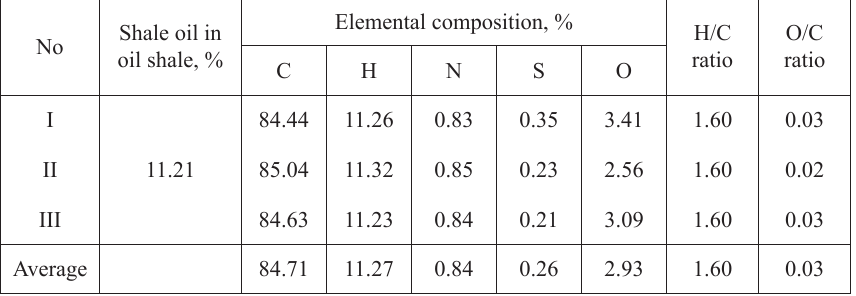
Table 4. Fractional composition of shale oil, wt%